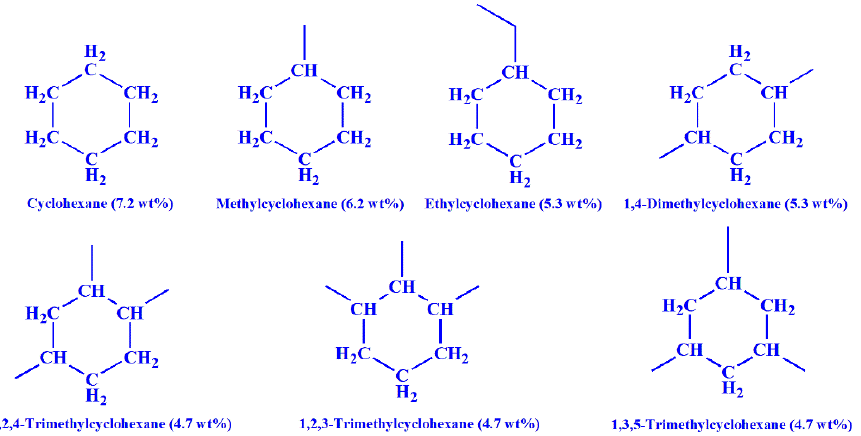
Figure 7. The molecular structure and hydrogen storage density of the chosen